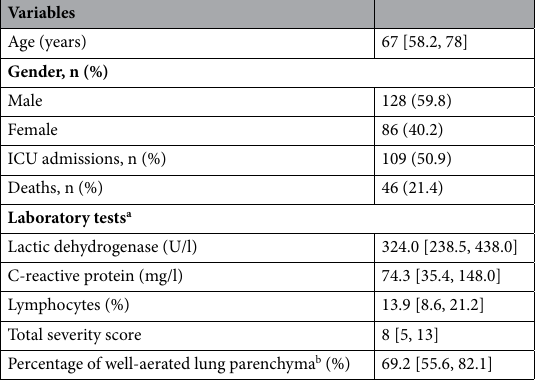
Table 1. Demographics, clinical characteristics, laboratory information, and reference predictors for the patient cohort. Continuous variables are expressed in terms of the median [interquartile range: Q1, Q3]. a For a sub-cohort of 175 patients. b For a sub-cohort of 209